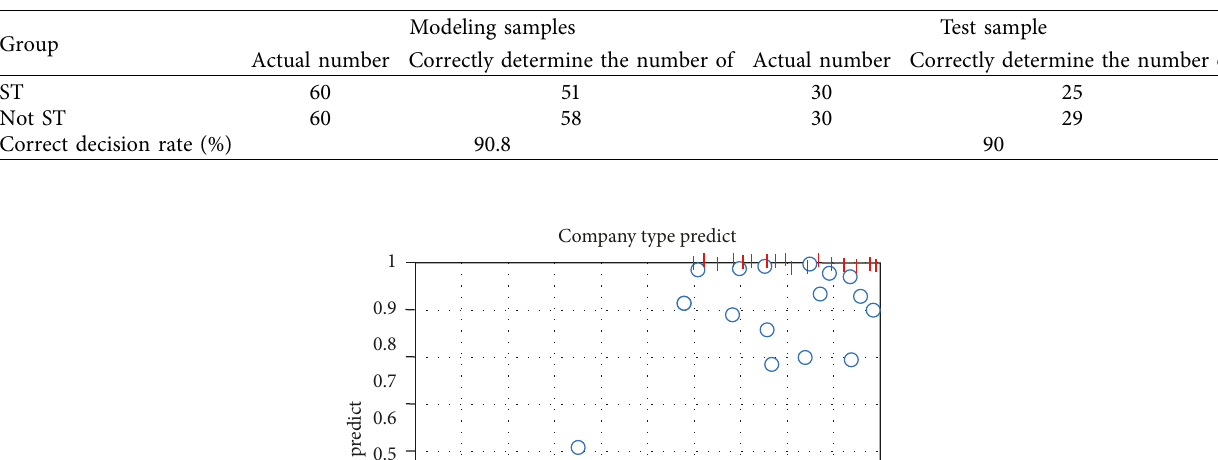
Table 1: BP neural network model prediction and test result table.